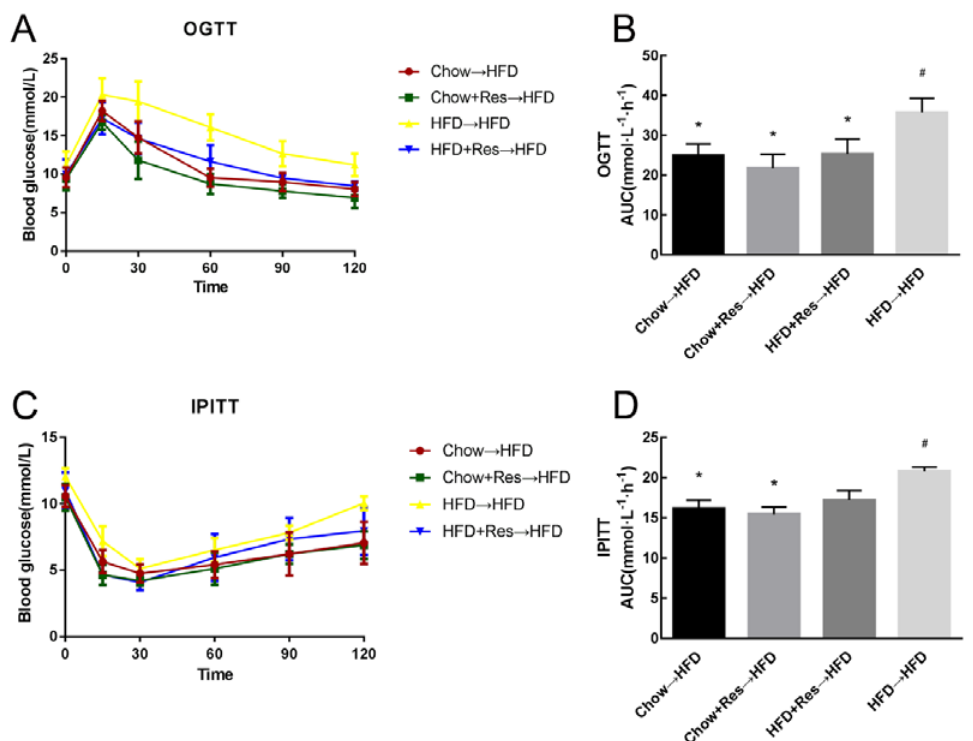
Figure 6. Resveratrol (RES) fecal transplants improved glucose homeostasis in high-fat diet (HFD)-fed mice. ( A ) Blood glucose levels and ( B ) Area under the curve (AUC) during the oral glucose tolerance test (OGTT). ( C ) Blood glucose levels and ( D ) AUCs during the intraperitoneal injection of insulin tolerance test (IPITT). * p < 0.05; compared with HFD → HFD, # p < 0.05; compared with Chow → HFD, ( n =